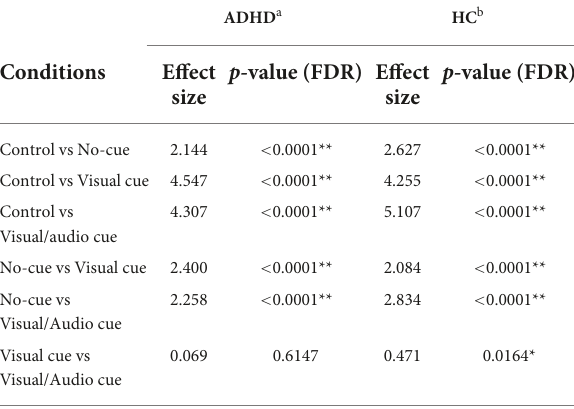
TABLE 3 Post-hoc analysis results for the linear mixed model on the main effect of condition.